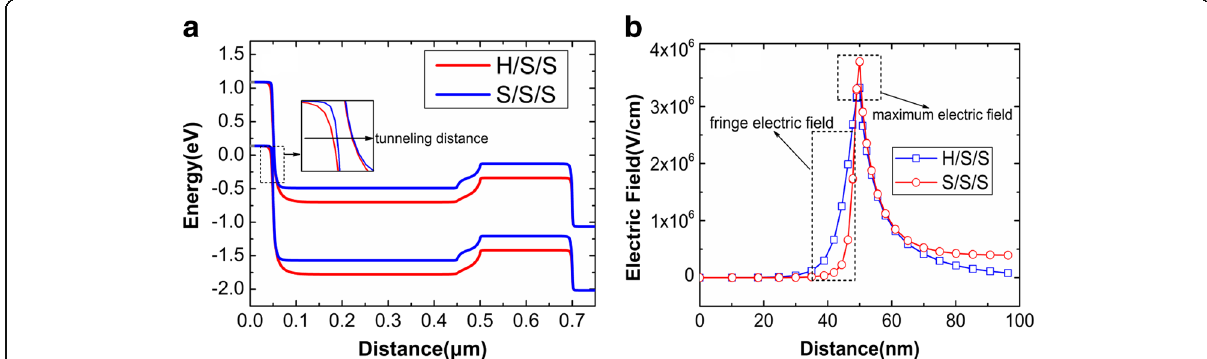
Fig. 6 a Energy band from source to drain and b electric field at the top of source tunneling